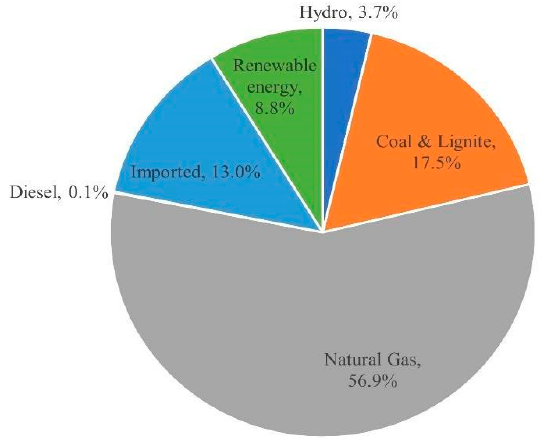
Figure 4. Thailand electrical grid mix [30].